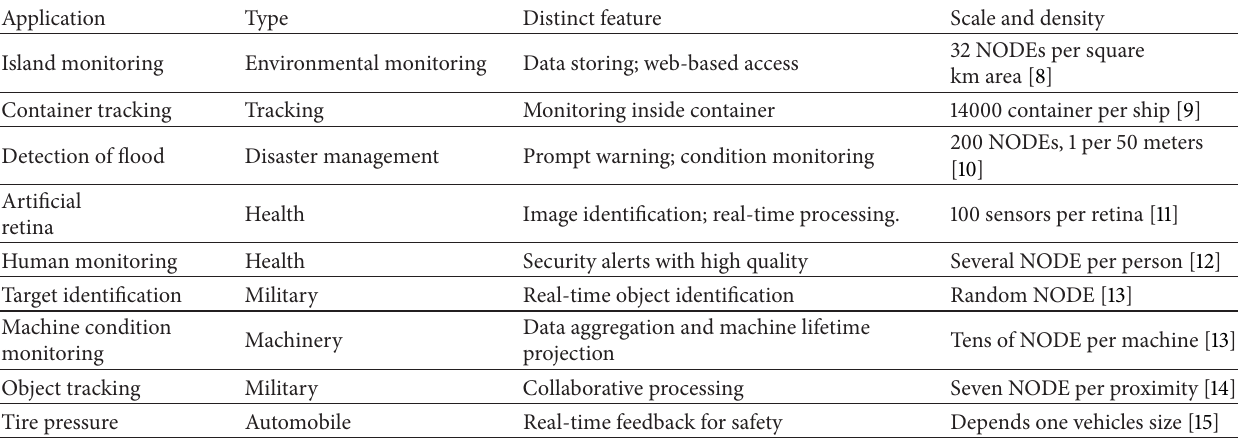
Table 1: Example of some prototype WSN deployment